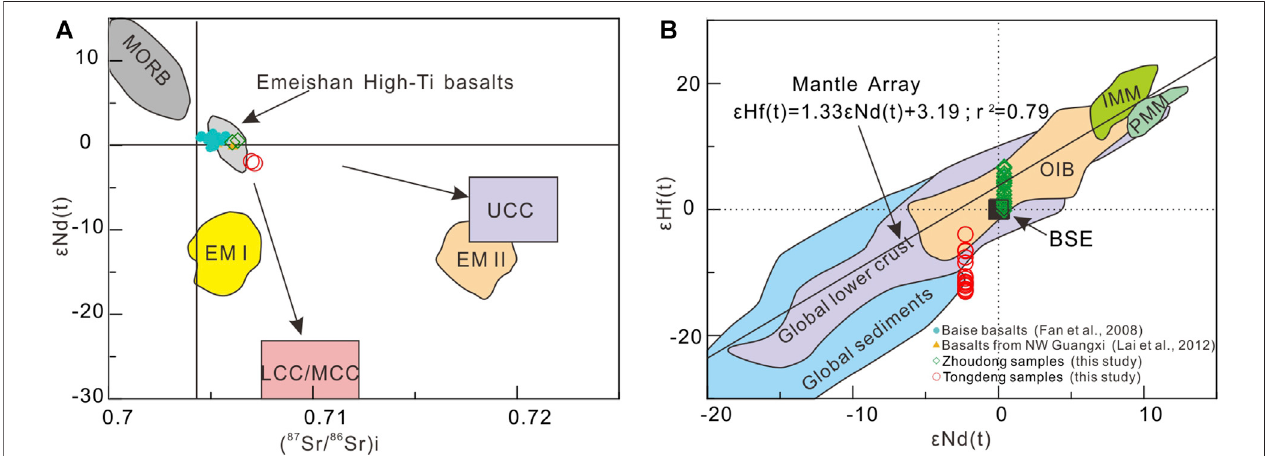
FIGURE 8 | (A) ( 87 Sr/ 86 Sr) i - ε Nd(t) and (B) ε Hf(t)- ε Nd(t) (base map after Vervoort et al., 1999 and Zeng et al., 2021a; Zeng et al., 2021b) diagrams for the Longlin basaltsamples.MORB,mid-ocean-ridgebasalt;EMIandEMII,enrichedmantle;HIMU,LCC/MCC,middletolowercontinentalcrust;UC,uppercontinentalcrust;IMM, Indian MORB;PMM,Paci fi cMORB.Datasource:therangesofEmeishanhigh-andlow-TibasaltsarefromXuetal.(2001),Zhouetal.(2006)andXiaoetal.(2003),Xiao etal.(2004)a,b;DM,EMI,andEMII(ZindlerandHart,2003);LCC,MCC,andUC(Jahnetal.,1999);globalsedimentsfromVervoortetal.(1999);globallowercrust from Vervoort et al. (2000); IMM and PMM from Kempton et al. (2012).